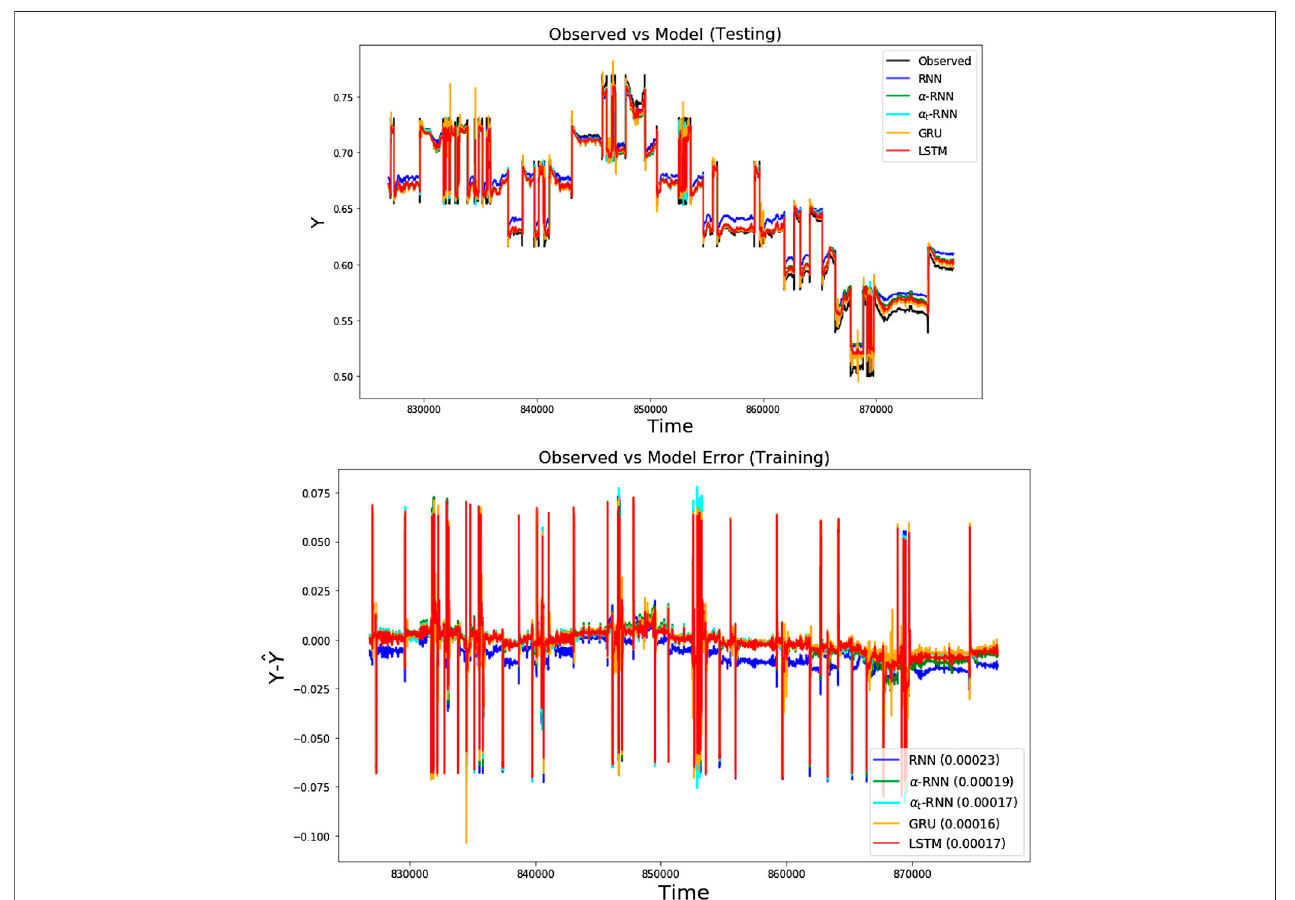
FIGURE5| Theten-stepaheadforecastsofVWAPsarecomparedforvariousarchitecturesusingthetick-by-tickdataset.( top )Theforecastsforeacharchitecture and the observed out-of-sample time series. ( bottom ) The errors for each architecture over the same test period.